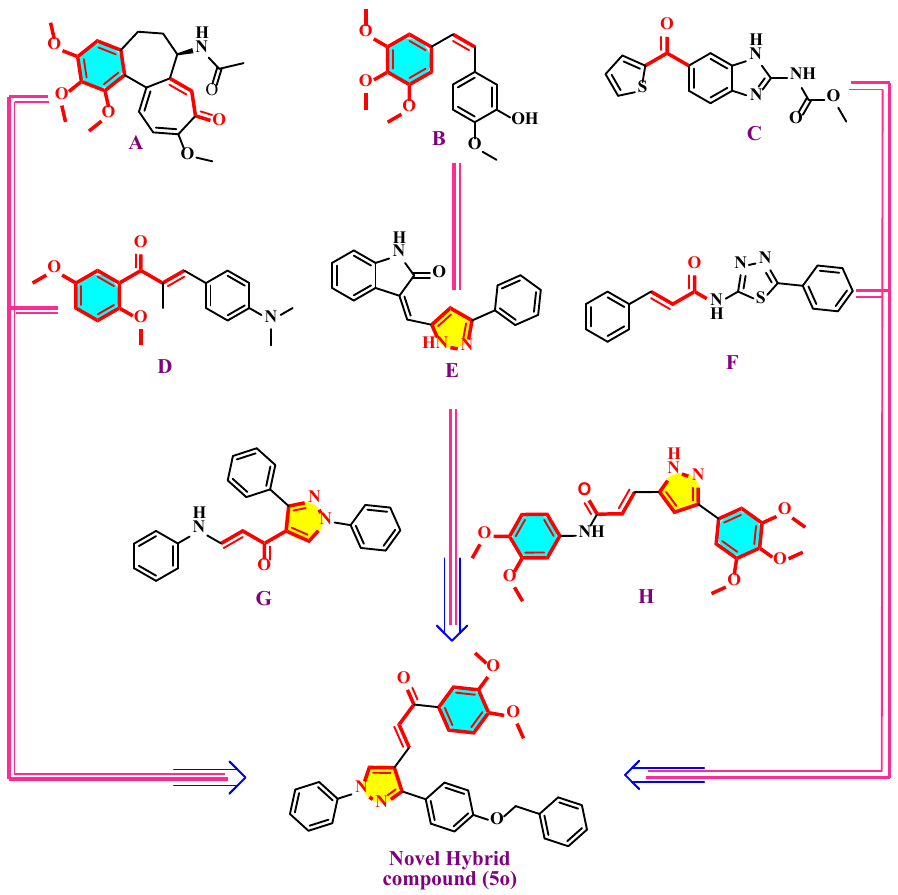
Figure 2. Structures of some potential cytotoxic agents and tubulin polymerization inhibitors: colchicine ( A ), combretastatin-A4 ( B ), nocodazole ( C ), MDL-27048 ( D ), reported pyrazole-linked conjugates ( E ), reported chalcone-linked conjugates ( F ), reported pyrazole-linked chalcone conjugates ( G , H ), and novel hybrid compound ( 5o ).